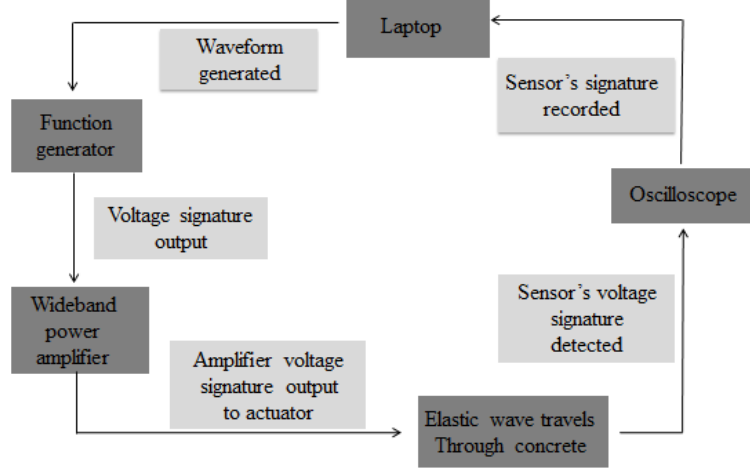
Figure 9. Typical experimental set-up of the wave propagation (WP) technique [113].